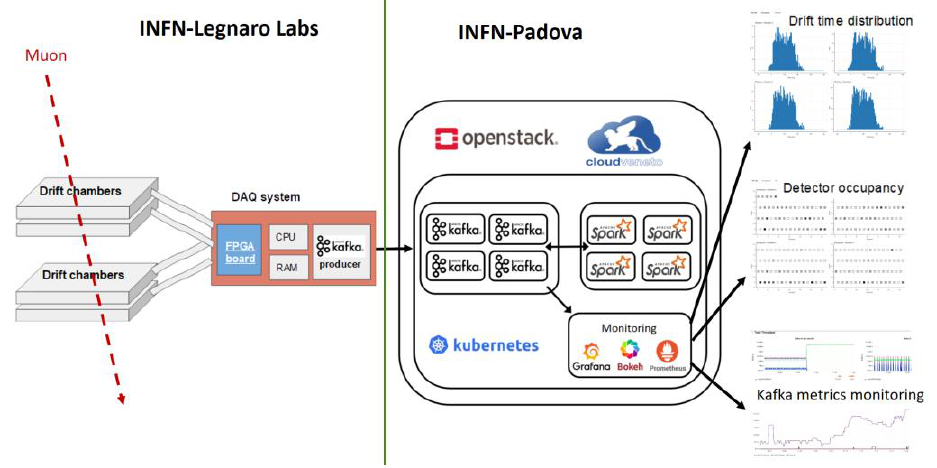
Fig. 3. Muon DT chambers Online data acquisition setup at INFN-Legnaro Labs and remote streaming processing through the Big Data Analytics platform of